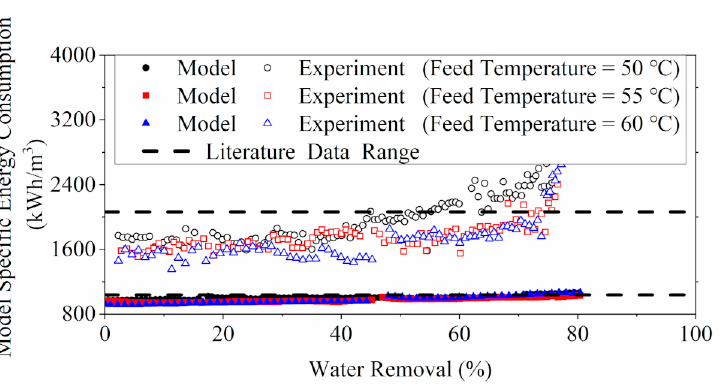
Figure 11. Comparison of the SEC computed from lab measurements (experiment SEC), the model SEC and the literature